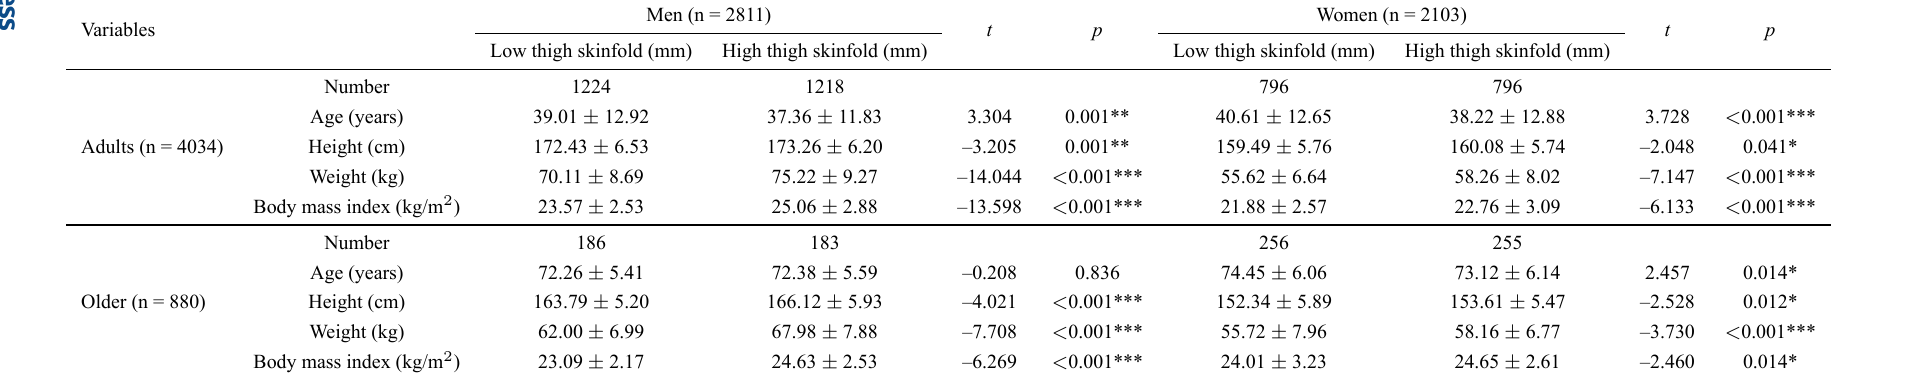
Table 1. Characteristics of all participants based on groups.